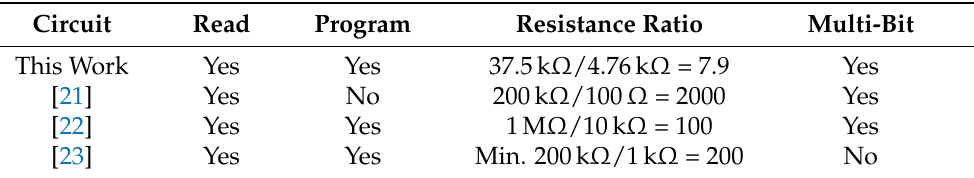
Table 5. Comparison of different read and programming